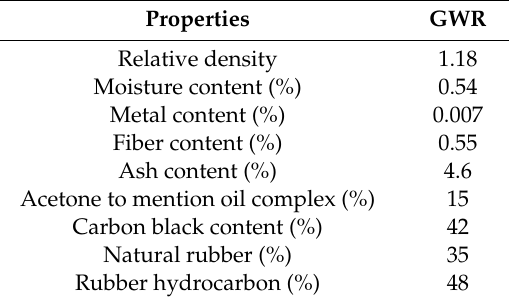
Table 4. Properties of GWR.